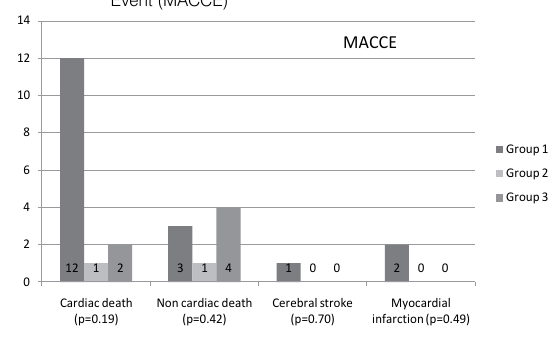
Figure 2. NYHA functional classifi cation before and after the treatment